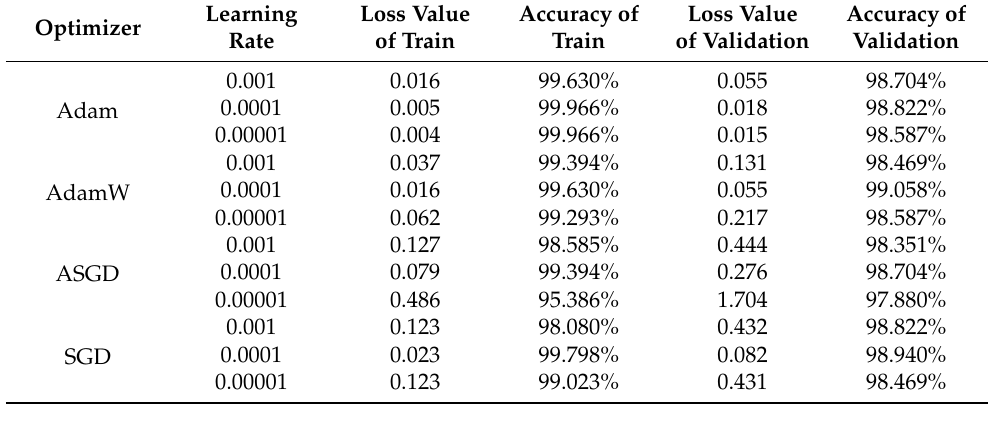
Table 2. Optimal results using different learning rates and optimizers.